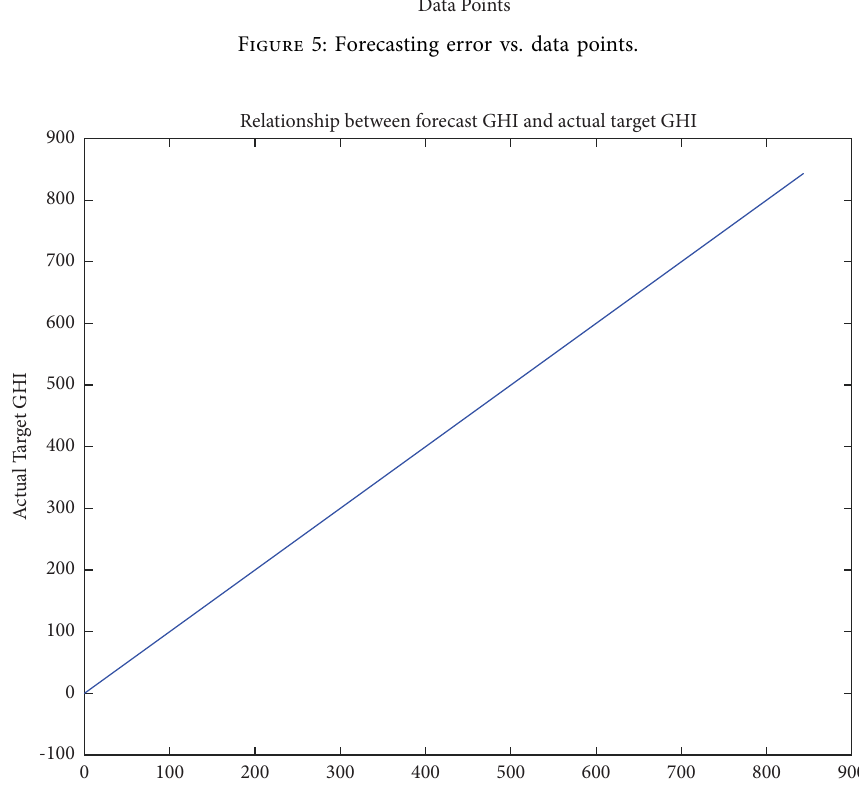
Figure 6: Relationship plot between forecast GHI and actual target